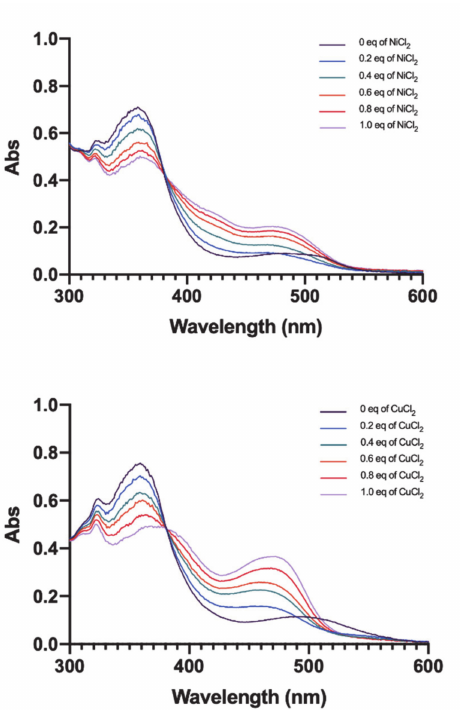
Figure 3. UV–vis titrations of C with nickel(II) chloride (top) and copper(II) chloride